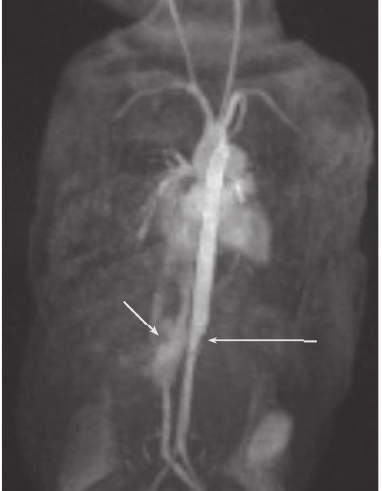
Figure 2: Coronal postcontrast twist sequence (time resolved gadolinium enhanced MRI) with multiphase following intravenous injection of gadopentetate dimeglumine. Arterial phase evaluation of the abdomen demonstrated a definite change in caliber of the abdominal aorta at the level of the midliver with narrowing of its subdiaphragmatic portion (long arrow). Additionally, between the IVC and the aorta, in the region of the left lobe of the liver, a vascular structure fills the left lobe of the liver (short arrow), communicating with a large left hepatic vein draining into the right